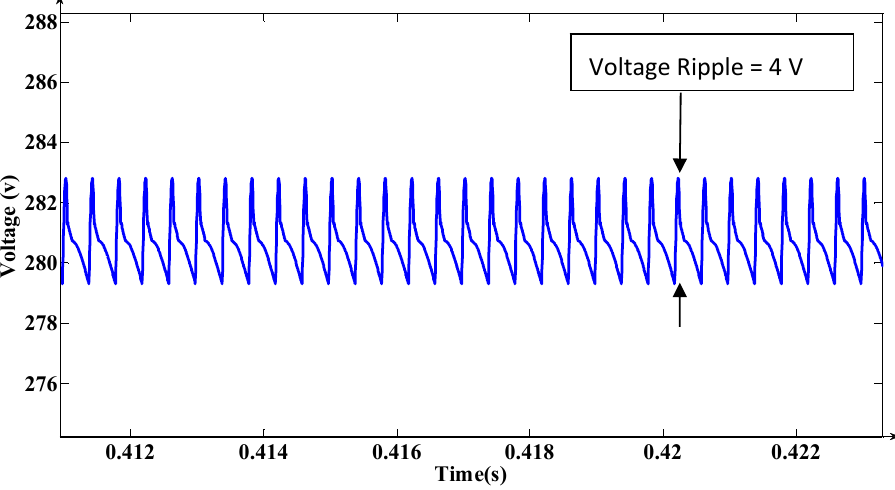
Figure 37. Output voltage waveform for PI-controlled bidirectional converter (BDC).